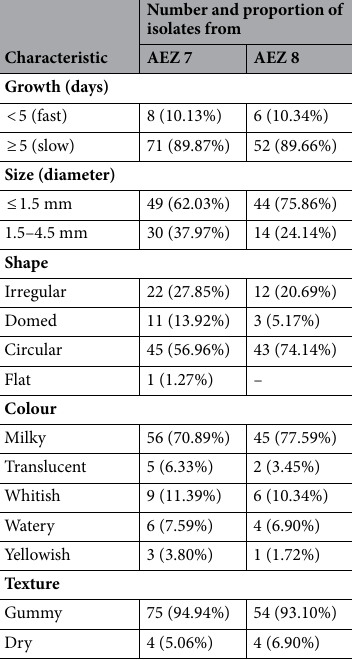
Table 1. Summary of the morpho-physiological characteristics of native rhizobial strains tested. AEZ agroecological